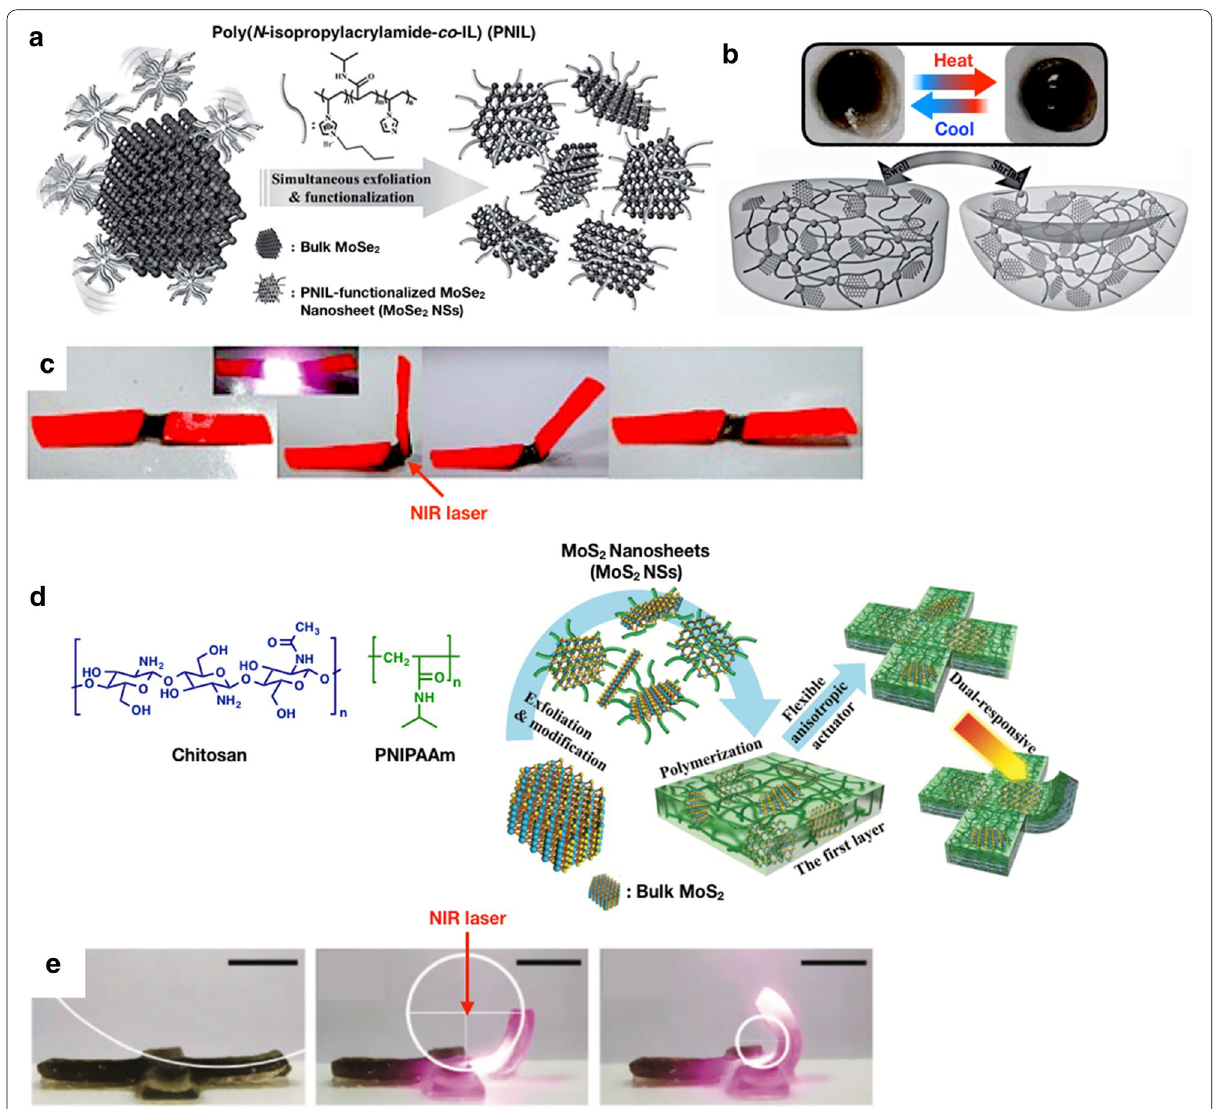
Fig. 9 a Overall preparation scheme of the simultaneous exfoliation and noncovalent functionalization of MoSe 2 NSs with PNIL. b Image of the MoSe 2 NSs immobilized hydrogel at 25 °C and 55 °C. c Image of the bending of the MoSe 2 NSs immobilized hydrogel upon 808 nm irradiation for 3 min. ( a – c were reproduced with permission from Ref. [61], © 2016, Wiley–VCH Verlag GmbH & Co. KGaA, Weinheim). d Schematic images of the exfoliation and modification of MoS 2 NSs with chitosan and synthesis of the bilayered hydrogel composed of PNIPAAm/MoS 2 NSs layer and chitosan/DMA/LAPONITE layer. e Images of the response of the MoS 2 NSs immobilized hydrogel under 808 nm NIR irradiation (5 W/cm 2 ) for 70 s. ( d , e were reproduced with permission from Ref. [62], © 2016, The Royal Society of